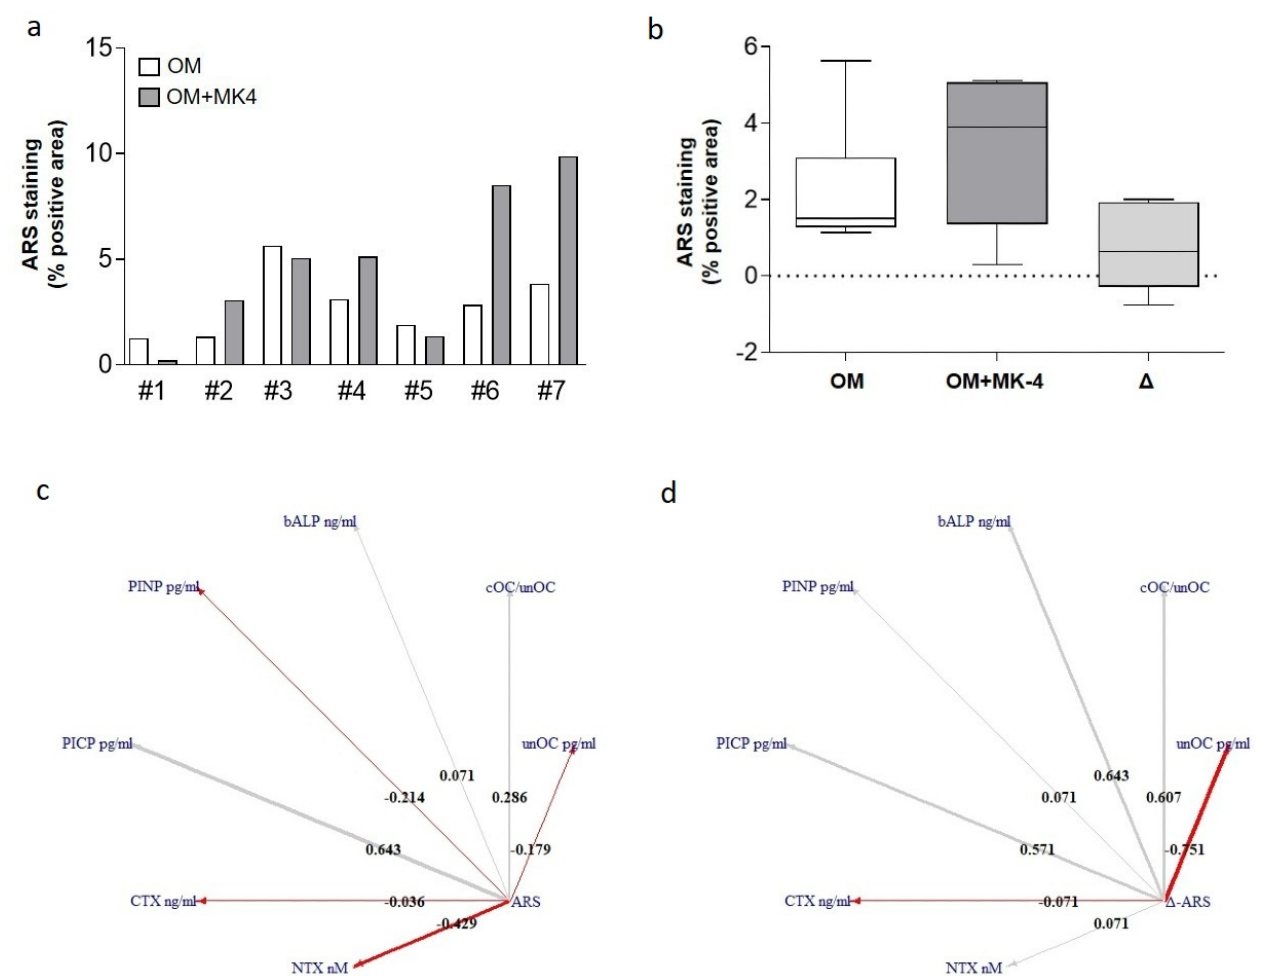
Figure 6. Effect of MK-4 on each hOBs/hMCs aggregates and CNA for BTMs. Panel ( a ) shows the ARS (% positive area) for each sample. Baseline (OM), after MK-4 treatment, and relative differences for ARS (Δ -ARS) are shown as a box-plot ( b ). Ego-centered network for ARS ( c ) and Δ -ARS ( d ), respectively. The weight of the arrow indicates the correlation coefficient of Spearman (rho), the red color indicates a negative correlation, the grey color a positive one, and the thickness of the arrow indicates the strength of the relationship.